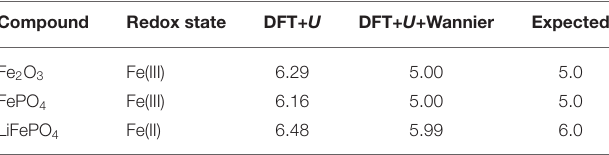
TABLE 4 | The computed here with different methods and measured (Iyer et al., 2006) formation enthalpies from oxides of FePO 4 and LiFePO 4 compounds.